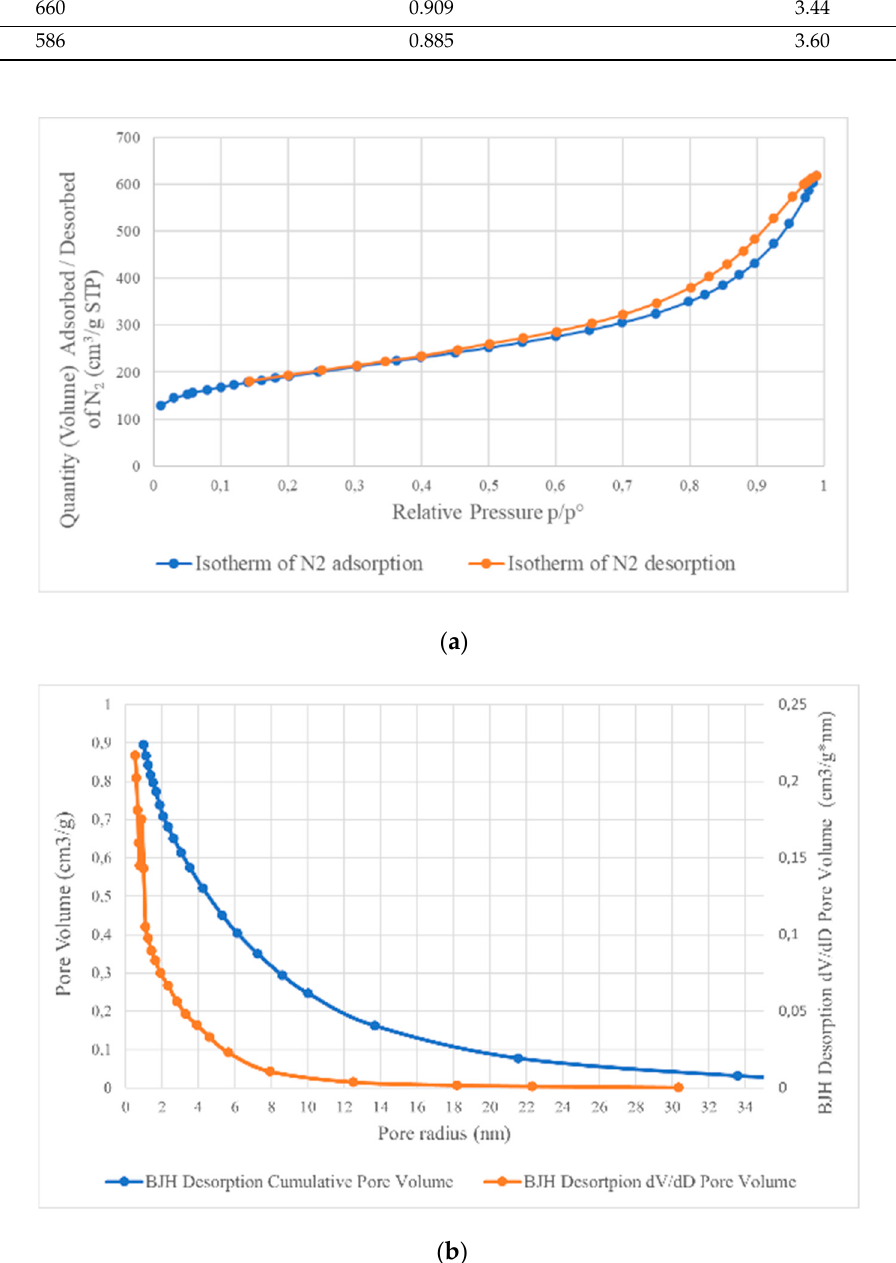
Figure 7. Adsorption–desorption isotherms of N 2 for A 1 sample ( a ) and its pore sizes ( b